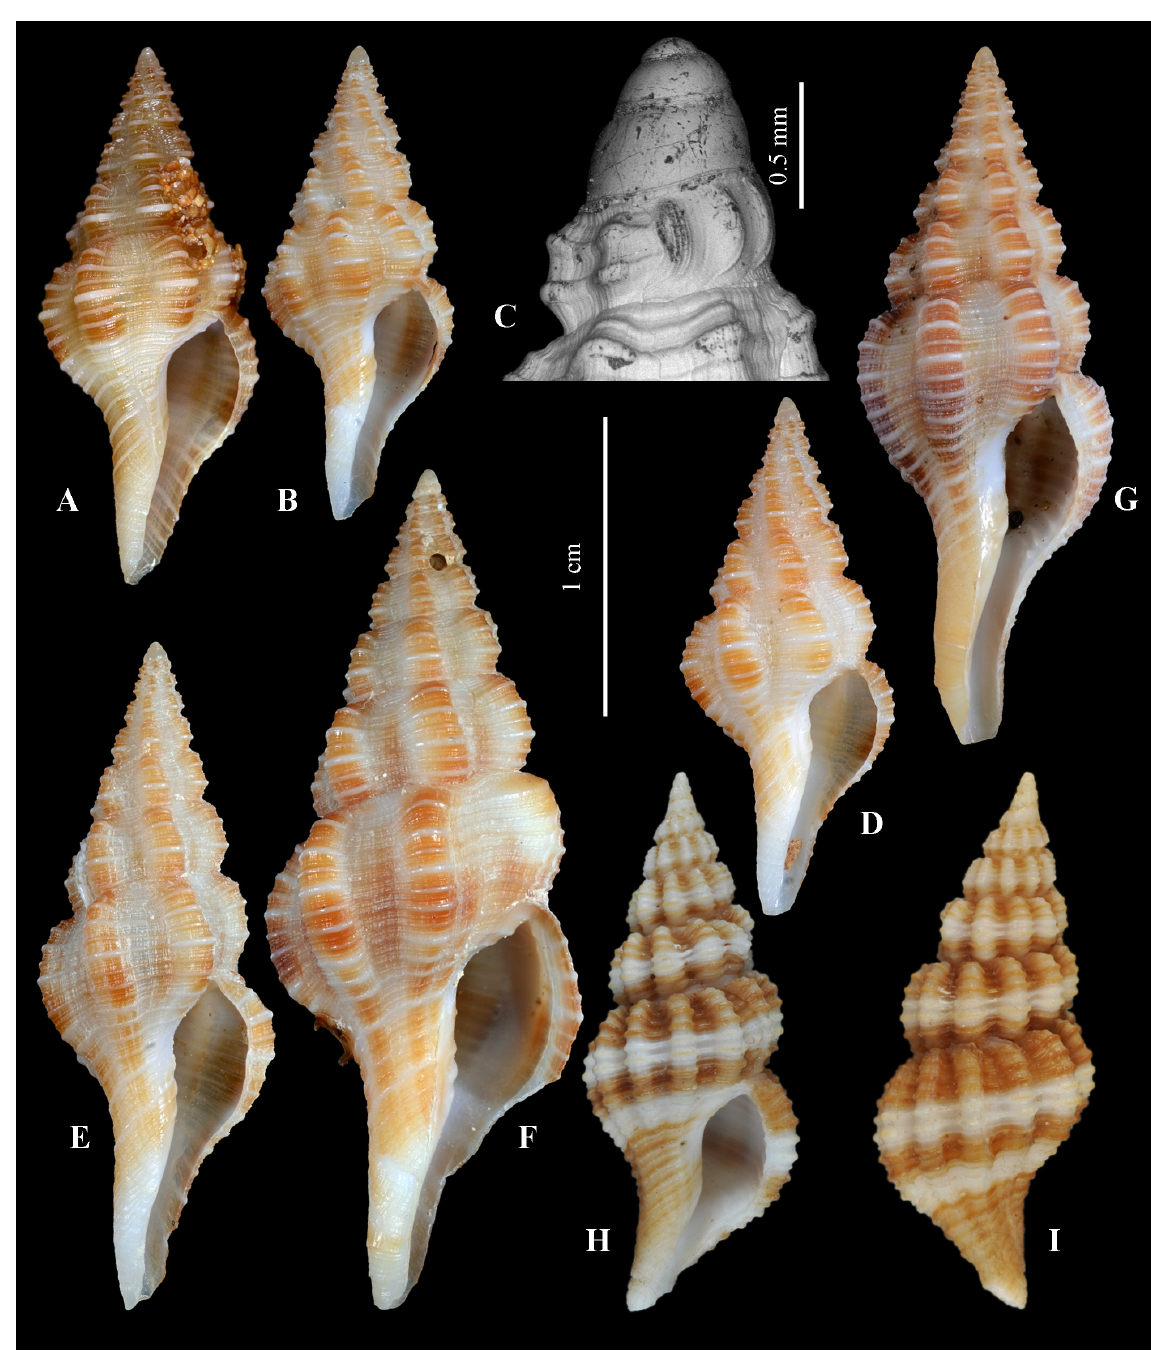
Fig. 9. A–G . Okutanius kuroseanus (Okutani, 1975) gen. et comb. nov. A . New Ireland, KAVIENG 2014, stn CP4503, 02°30′ S, 150°44′ E, 191–200 m, SL 18.1 mm , sequenced specimen; for radula, see Fig. 4G (MNHN IM-2013-59070). B . BORDAU 1, stn DW1469, 19°40′ S, 178°10′ W, 314–377 m, SL 15.9 mm. C . Protoconch, New Caledonia, BIOCAL, stn CP105, 21°31′ S, 166°22′ E, 330–335 m. D–E . Loyalty Ridge, MUSORSTOM 6, stn DW391, 20°47′ S, 167°06′ E, 390 m. D . SL 17.3 mm. E . SL 22.3 mm. F . Loyalty Ridge, MUSORSTOM 6, stn DW398, 20°47′ S, 167°06′ E, 370 m, SL 28.1 mm. G . Taiwan. TAIWAN 2000, stn DW34, 22°02′ N, 120°36′ E, 246 m, SL 23.4 mm. H–I . Okutanius aikeni (Lussi, 2014) gen. et comb. nov., holotype, SL 25.6 mm. A–B, D–G at the same scale, H–I not